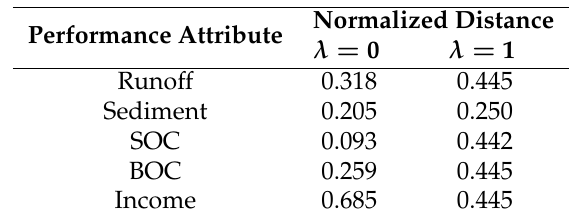
Table 10. Normalized distances of the solution produced by BIOLP for λ = 0 and λ = 1 (all weights were fixed to 0.2).